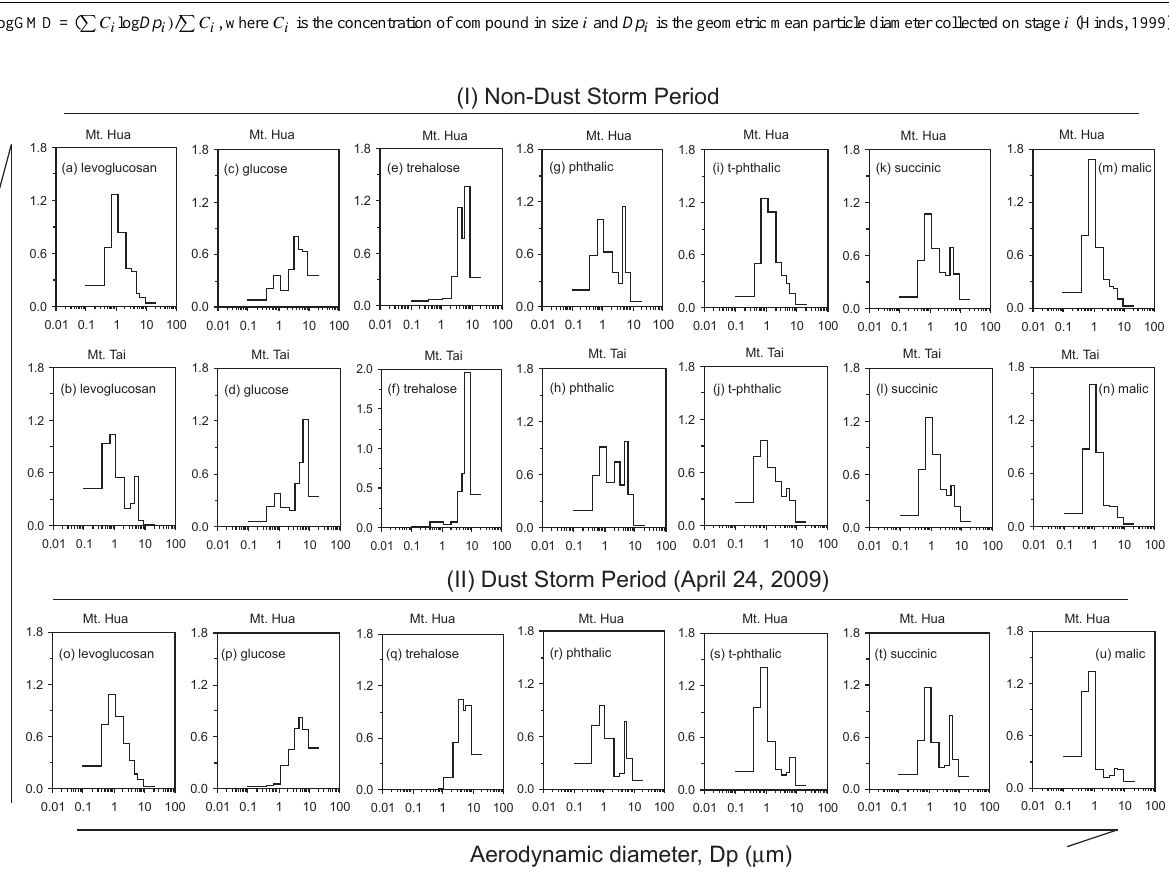
Fig. 10. Differences in size distributions of water-soluble organic aerosols at Mt. Hua and Mt. Tai during (I) the nonevent and (II) the event Figure 10. Differences in size distribution of water-soluble organic aerosols collected at Mt. Hua and Mt. Tai during (I) the non-dust storm and (II) the dust storm periods